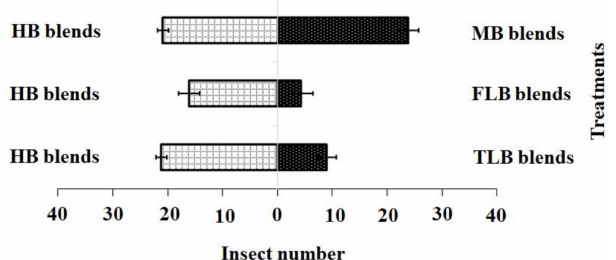
Figure 4. Responses of P. xylostella adult females to synthetic blends. HB, healthy B. vulgaris ; FLB, first instar larvae feeding on B. vulgaris ; TLB, third instar larvae feeding on B. vulgaris ; MB, mechanically damaged B. vulgaris. Bars represent the mean ( ± SE) response of adult female exposed to synthetic active volatile from Barbarea vulgaris plants. Di ff erent letters indicate di ff erences between two treatments at p < 0.05.